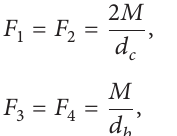
Figure 7: Applied load to the connection plate subjected to cyclic